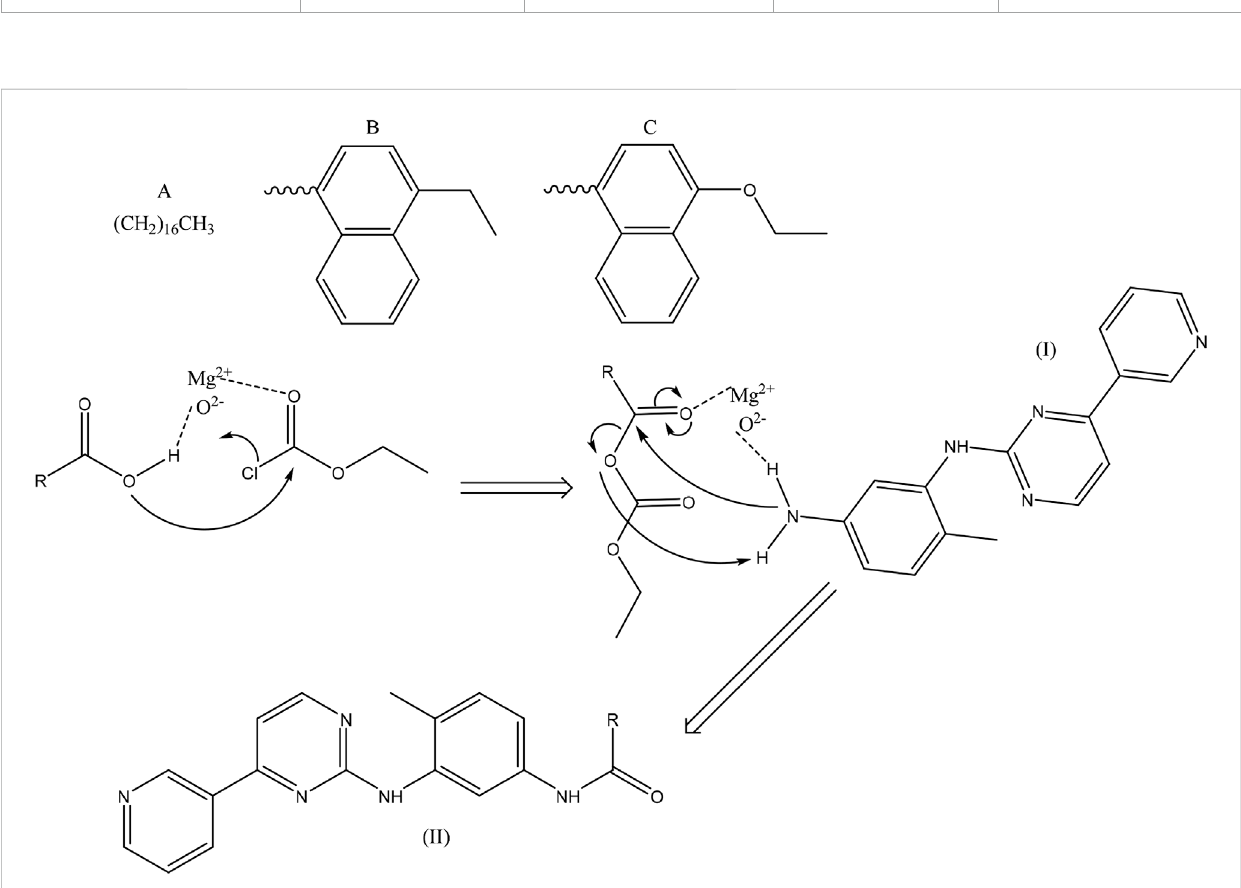
SCHEME 2 Proposed mechanism for the synthesis of